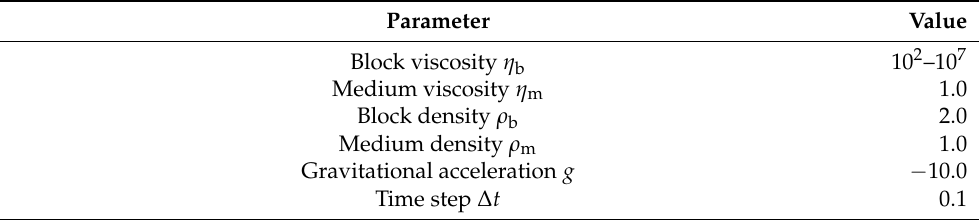
Table 2. Model parameters for the sinking block benchmark.